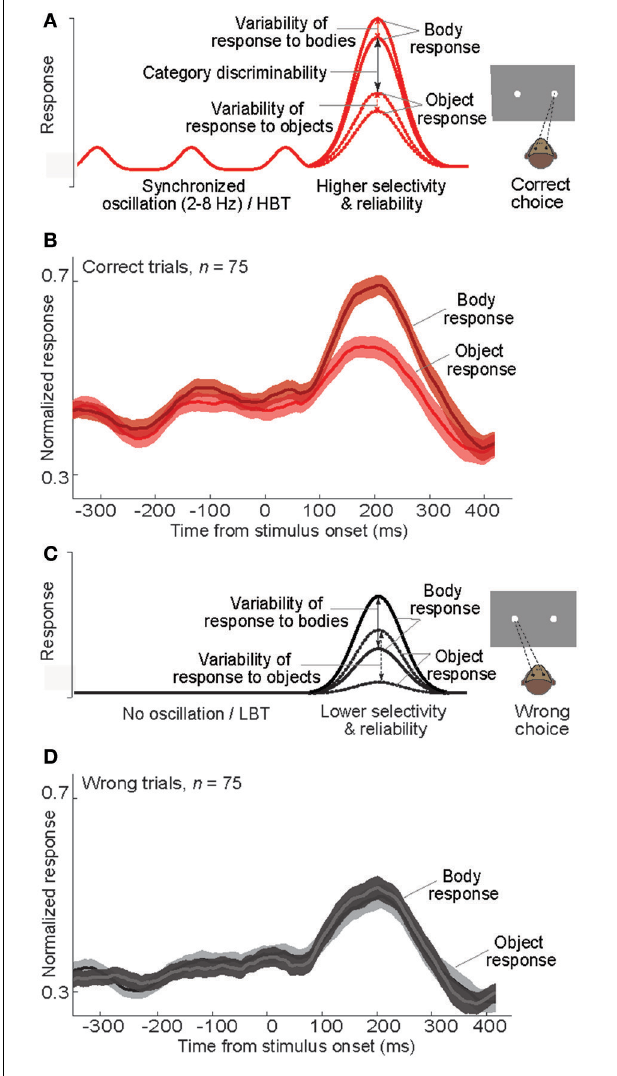
FIGURE 9 | Neural events following baseline modulation during a categorization task. (A) Schematic diagram of the mean response of a model body neuron responding to body and non-body images in “correct” trials. The impact of rhythmic baseline modulation on the neural response and behavior is illustrated. X-axis as in (B) . (B) Plot of normalized averaged firing rate of body neurons in correct trials. In each neuron and each signal level, the firing rates were normalized by the peak response, and then the normalized firing rates were averaged. (C) Schematic diagram of the mean response of a model body neuron responding to body and non-body images in “wrong” trials. The impact of no baseline activity on the neural response and behavior is illustrated. X-axis as in (D) . (D) Plot of normalized averaged firing rate of body neurons in wrong trials. Normalization was done similar to (B)